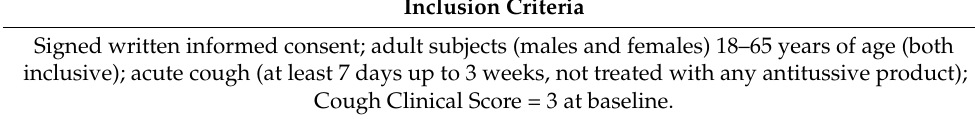
Table 1. Inclusion and exclusion criteria.